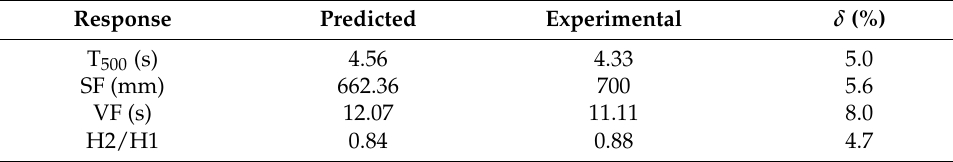
Table 5. Experimental validation and percentage error values.